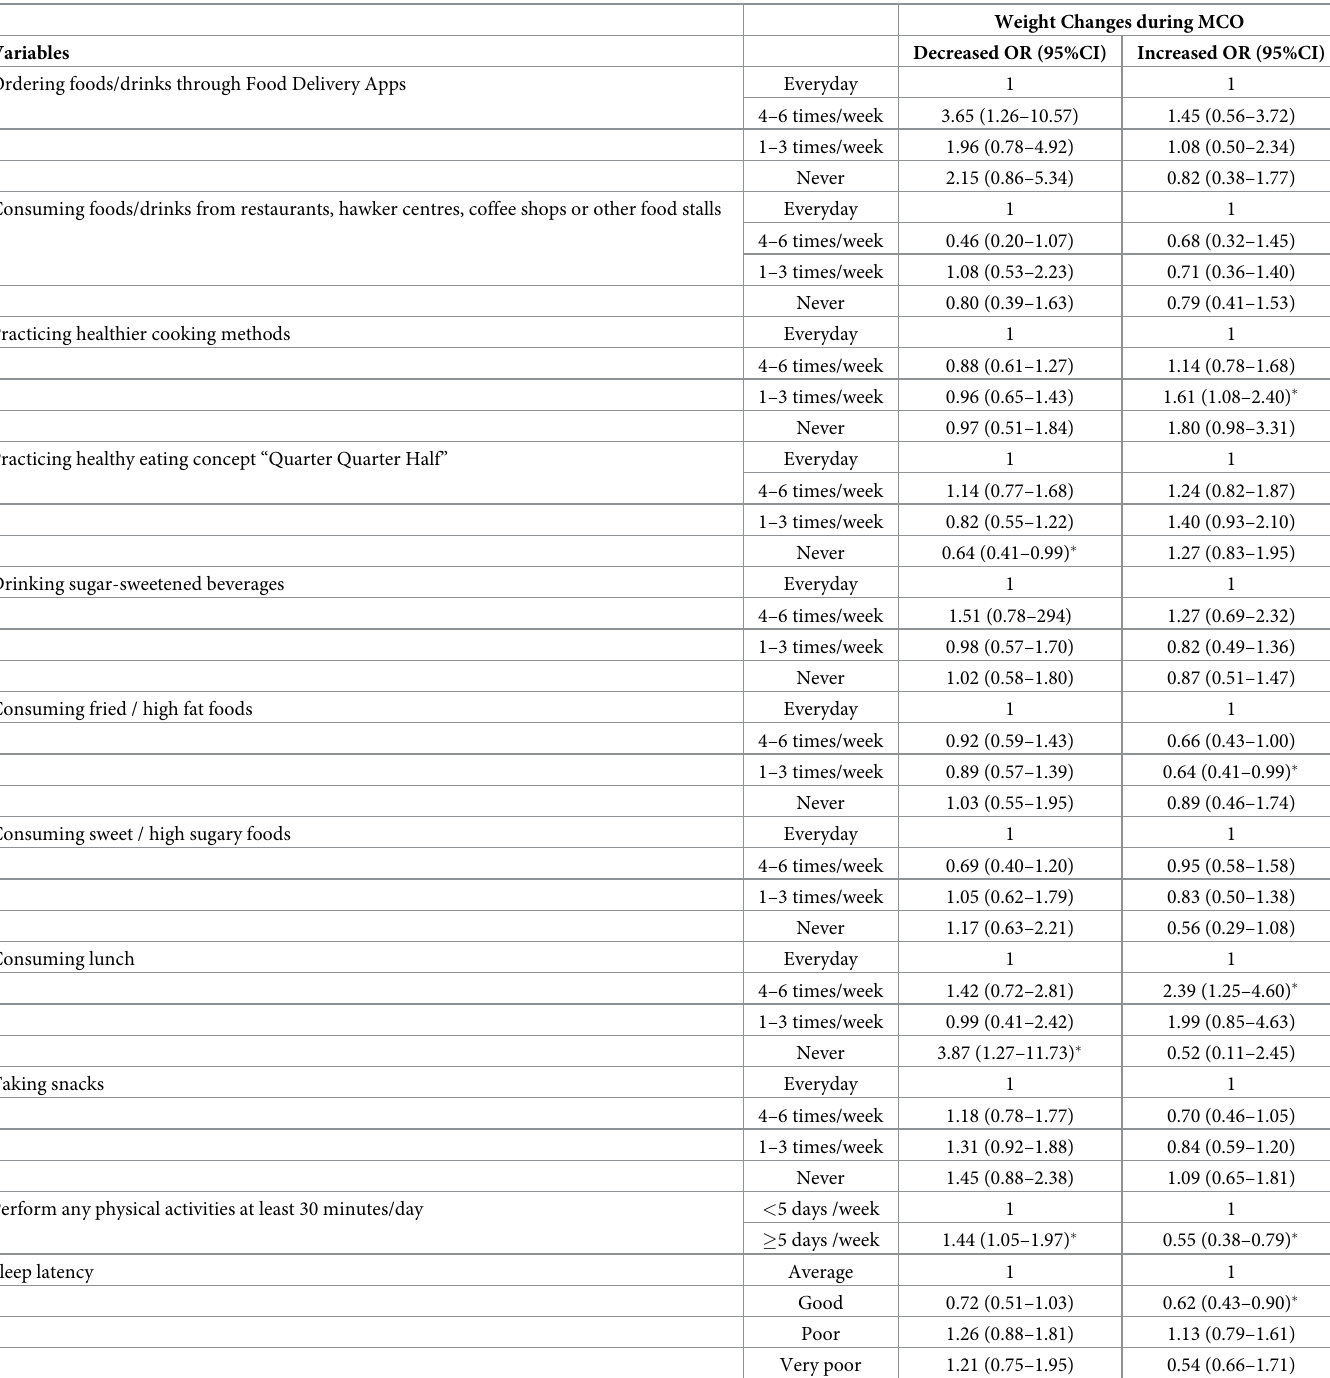
Table 4. Associations between lifestyle behaviours and body weight changes during